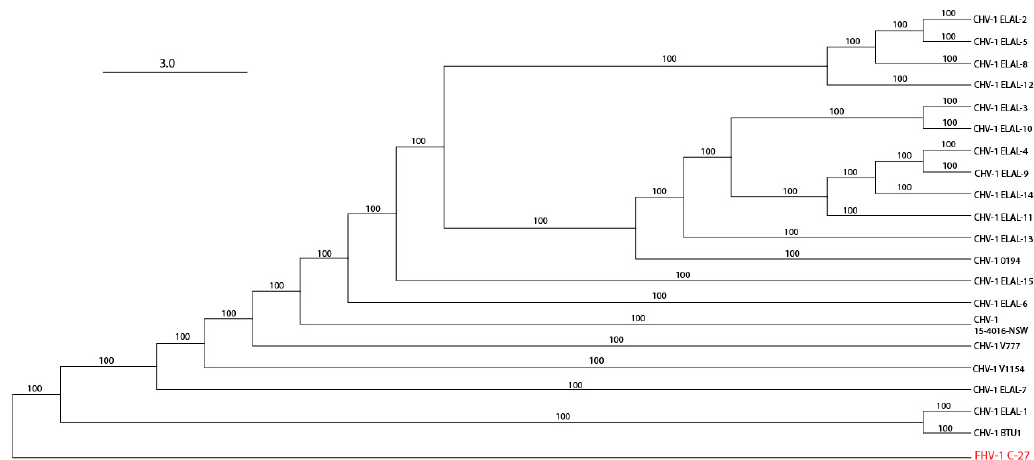
Figure 1. Maximum likelihood tree of all analyzed CHV-1 isolates with an FHV-1 C-27 outgroup (in red). Branch labels represent bootstrap support. Note the separation of two CHV-1 isolates (ELAL-1 and BTU-1) from the remaining CHV-1 isolates. CHV-1 ELAL-1 was obtained from a host animal in Texas in 2019 and BTU-1 was obtained from a host animal in Brazil in 2012.